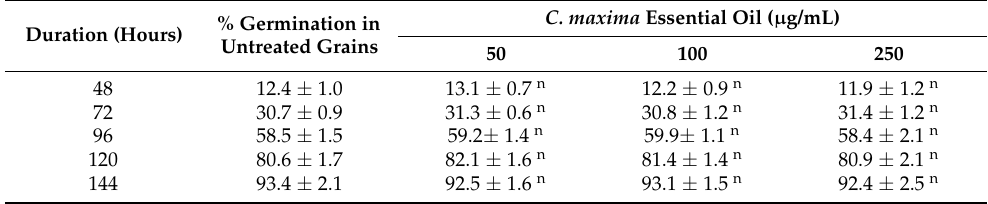
Table 6. Effect of CMEO on the ability of wheat germination (% germination).